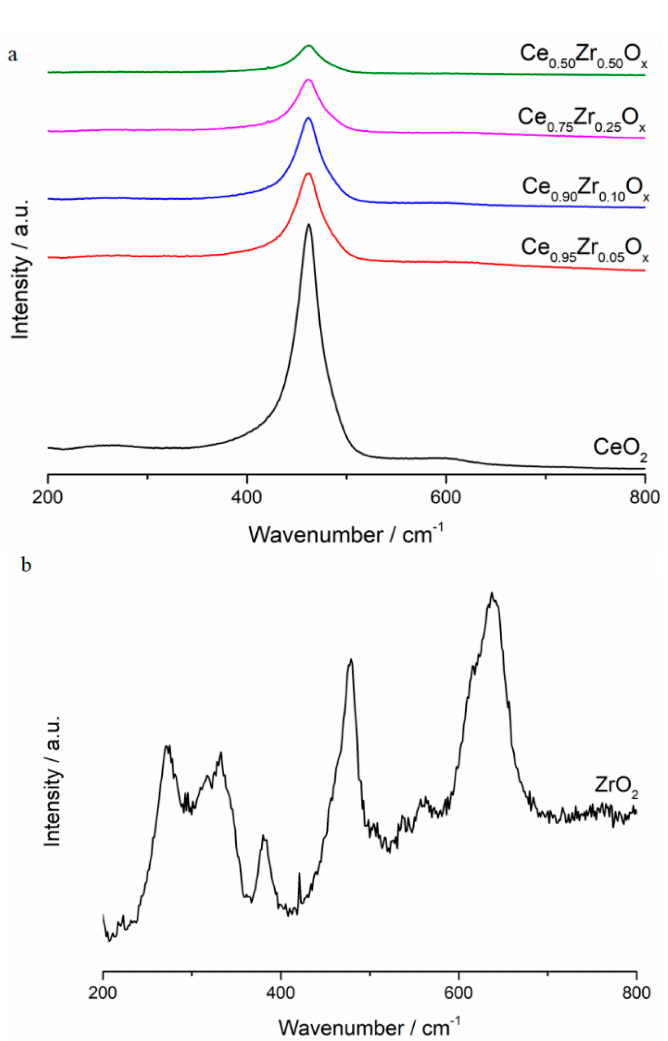
Figure 4. Laser Raman spectra for the ( a ) CeO 2 , Ce 0.95 Zr 0.05 O x , Ce 0.90 Zr 0.10 O x , Ce 0.75 Zr 0.25 O x , and Ce 0.50 Zr 0.50 O x , and ( b ) ZrO 2 spectra (enhanced 10 × ), prepared from carbonate